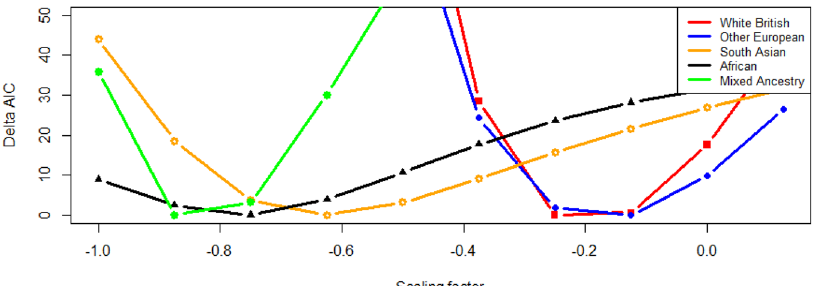
Fig. 1 | Determining optimal scale factors ( α ) for 5 different ancestry groups using GCTA- α model. GCTA- α model assumes that all SNPs have an equal con- tributiontotheheritabilityestimationand α valuevariesacrossancestries 20,21 . Δ AIC valuesfromGCTA- α modelsareplottedagainstscalingfactors, α ,foreachancestry